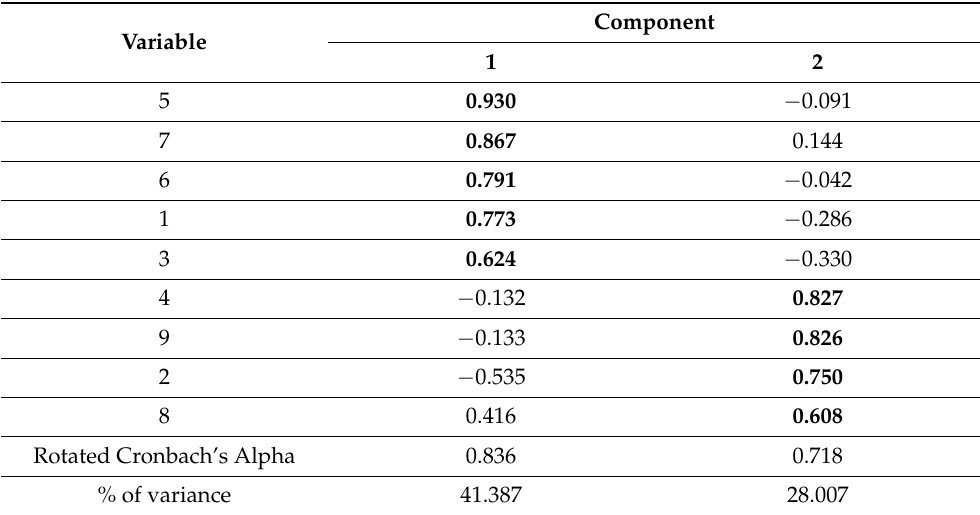
Table 6. Rotated component loadings for 2